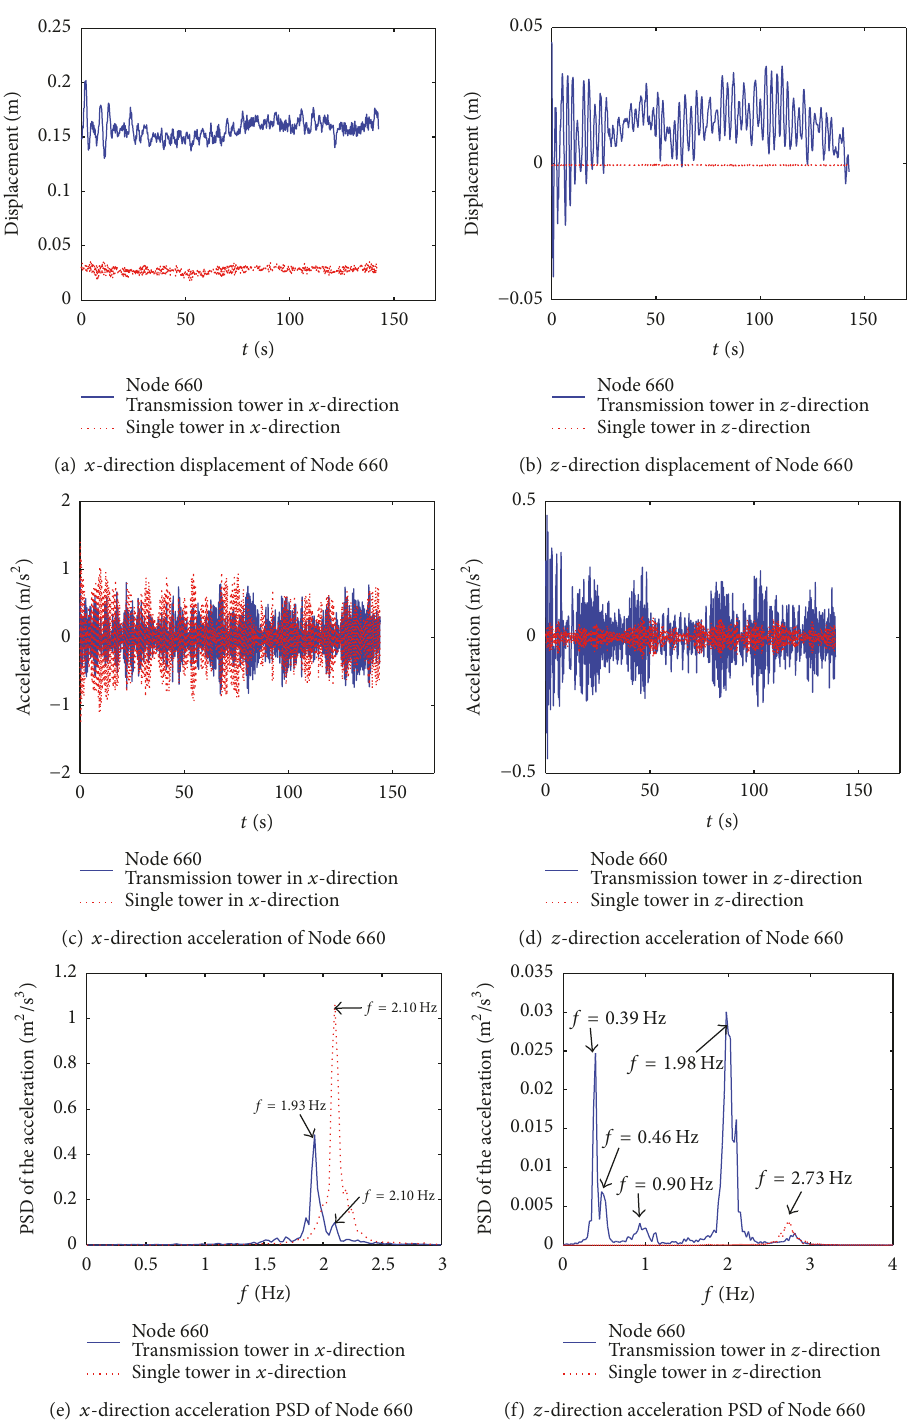
Figure 21: Steady-state response of Node 660 of the tower under the design wind speed ( 𝑈 10 = 25.3 m/s).